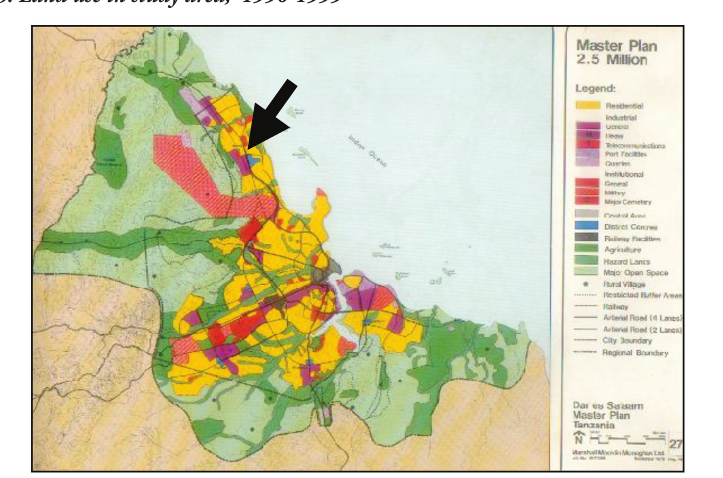
The Contribution of Ineffective Urban Planning Practices to Disaster and Disaster Risks ... Figure 3: Land use in study area,